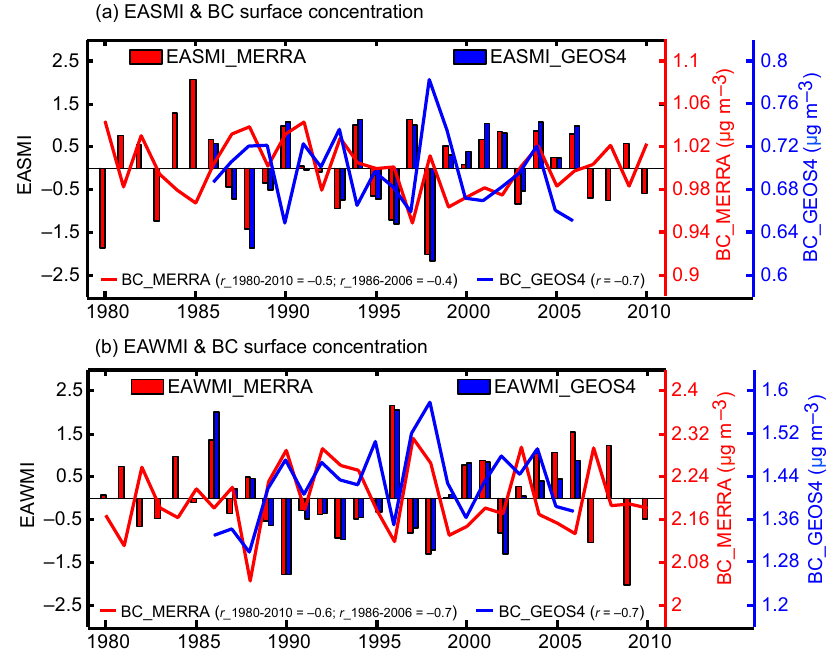
Figure 1. (a) Normalized East Asian summer monsoon index (EASMI, bars, left y axis) and the simulated June–July–August (JJA) mean surface BC concentrations (lines, right y axis, µgm − 3 ) averaged over eastern China (20–45 ◦ N, 110–125 ◦ E) from model simulation VMET (red line) for 1980–2010 and from VMETG4 (blue line) for 1986–2006. EASMI are calculated based on MERRA (red bars) and GEOS-4 (blue bars) assimilated meteorological data following Li and Zeng (2002). (b) Same as panel (a) , but for normalized East Asian winter